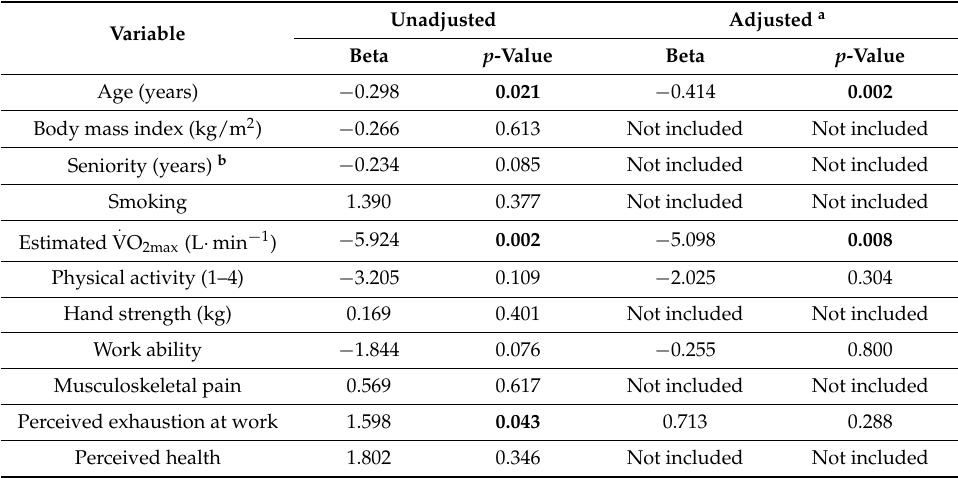
Table 3. Unadjusted and adjusted regression analyses with mean percentage relative heart rate at work as depentent